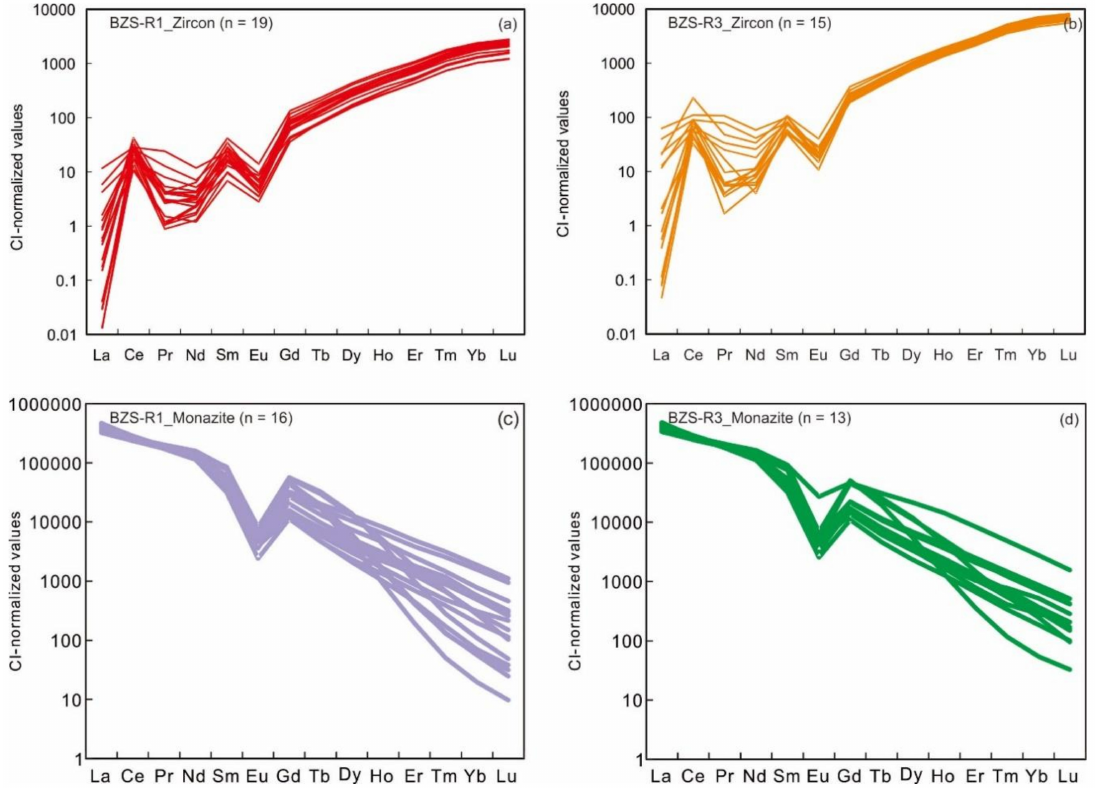
Figure6. ( a , b )Chondrite(C1)-normalizedREEdistributionpatternsofzircongrainsfromtheBozhushan batholith. ( c , d ) C1-normalized REE distribution patterns of monazite grains from the Bozhushan batholith. The elemental abundances of C1 were from